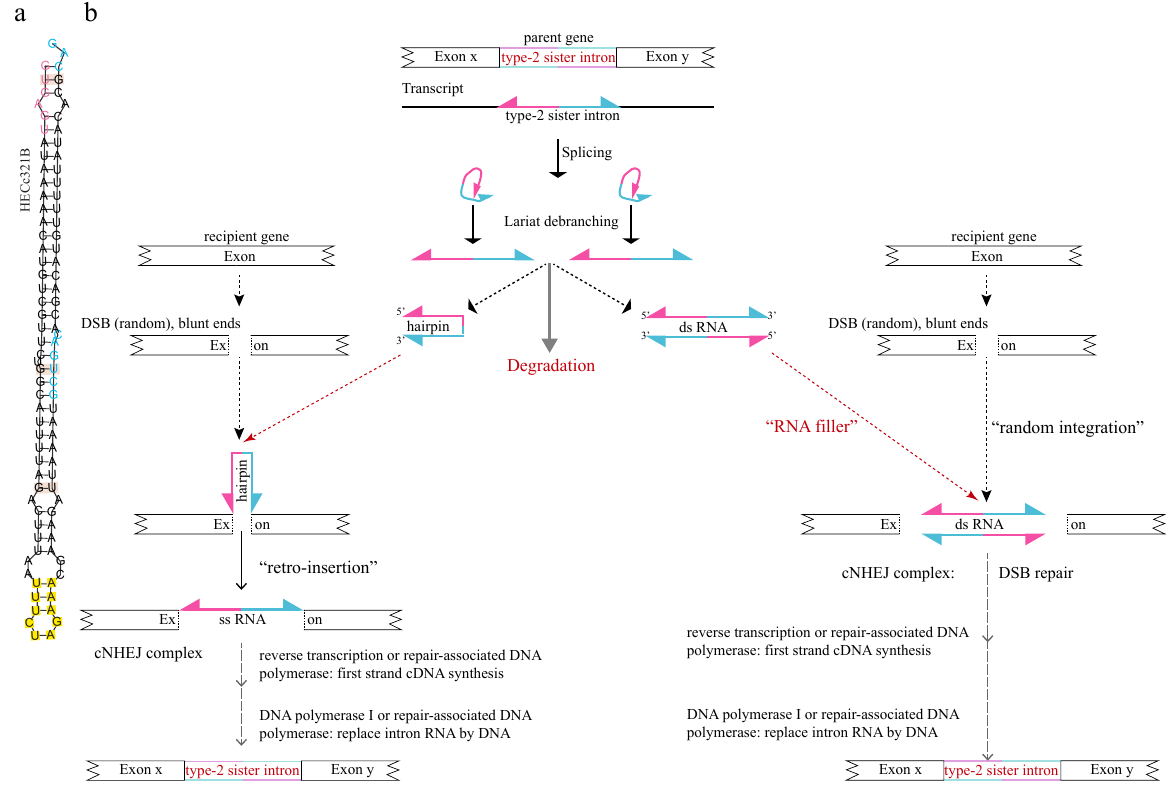
Figure 6. Proposed mechanisms to account for the proliferation of a highly symmetrical type-2 cropped sister intron during DSB repair. ( a ) Hairpin structure of HECc321B single-stranded intron RNA as predicted by RNAfold. The three noncanonical GU base pairings (salmon pink) and the 10-nt palindrome 5 (cid:48) -TTTCTAGAAA (yellow) are marked by differently coloured backgrounds. The 5 (cid:48) -donor, 3 (cid:48) -acceptor and BP elements are highlighted magenta or turquoise. ( b ) Two proposed